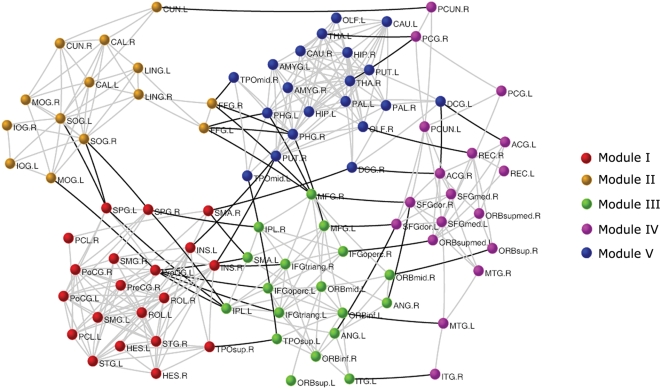
The modular architecture of the human brain functional network.We identify five functional modules in the spontaneous brain functional network represented by five different colors. The geometric distance between two brain regions on the drawing space approximates the shortest path length between them. The network is visualized with the Pajek software package (http://vlado.fmf.uni-lj.si/pub/networks/pajek/) using a Kamada-Kawai layout algorithm. The intra-module and inter-module connections are shown in gray and dark lines, respectively. For the abbreviations of the regions, see Table S1.